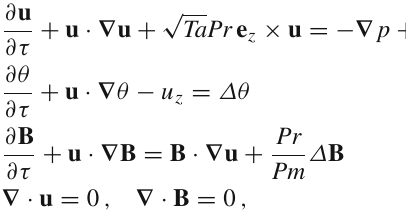
where the momentum equation has been written in the rotating frame, lengths are measured in terms of the thickness of the convection layer d , times are defined with respect to the thermal diffusion time τ κ = d 2 /κ ( κ is the thermal diffusivity), the total magnetic field B is expressed in terms of the Alfvén speed V A = B o / temperature deviations θ to the initial linear temperature profile are measured in